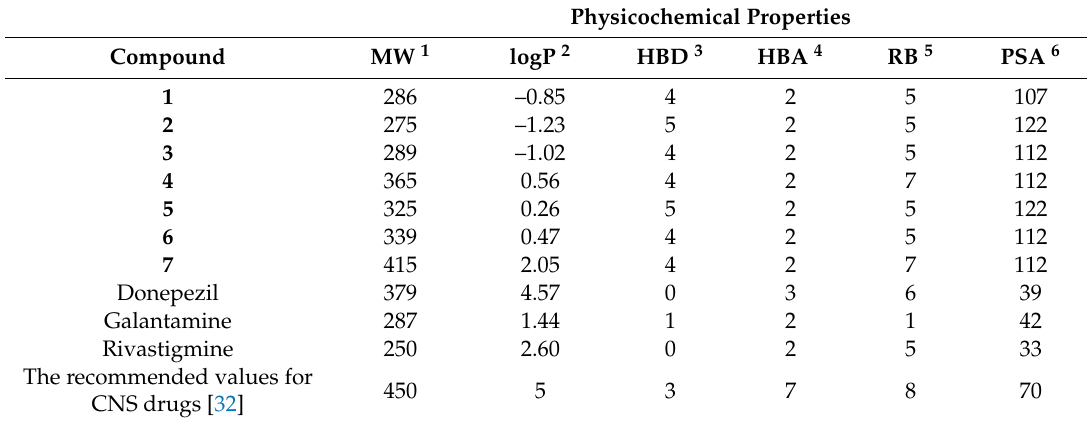
Table 2. Comparison of physicochemical properties for compounds 1 – 7 with recommended values for the central nervous system (CNS) active drugs. Known anti-AD (Alzheimer’s disease) drugs donepezil, galantamine, and rivastigmine are given for